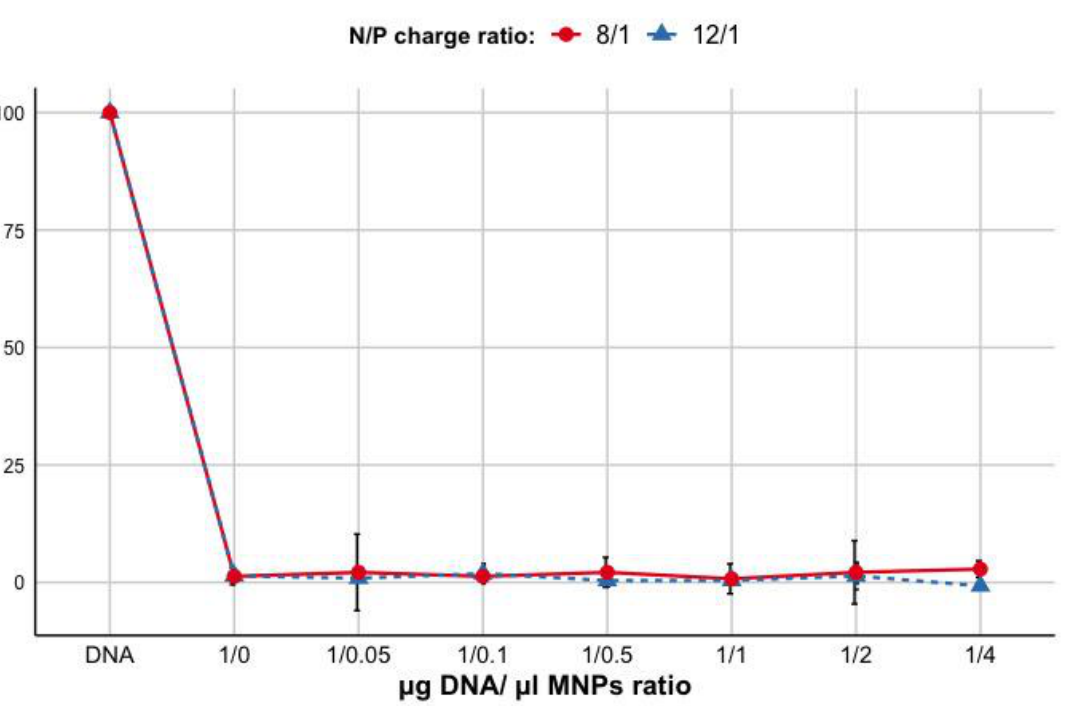
Figure 2. Efficiency of DNA protection from nuclease degradation within R6p-cRGD/DNA/MNPs polyplexes after DNase I enzyme digestion. The polyplexes containing 0.5 µg of DNA were treated with 0.2 units of DNase I for 30 min at 37 ° C. C− is DNA treated with DNase I; C+ is intact DNA. ( a ) R6p-cRGD/DNA N/P ratio is of 8/1; ( b ) R6p-cRGD/DNA N/P ratio is of 12/1. 3.2. DNA Release after DTT and DS Treatment of the Polyplexes To prove the disulphide bonds role in the formation of R6p-cRGD/DNA in MNPs-containing polyplexes, we applied dithiotreitol (DTT) as a reducible agent. DTT treatment was performed for MNPs-polyplexes at a 1:0.05 w/v ratio of DNA (μg) to MNPs (μL) (Figure 3a). We observed no destabilization of DNA condensation for all the tested MNPs-polyplexes